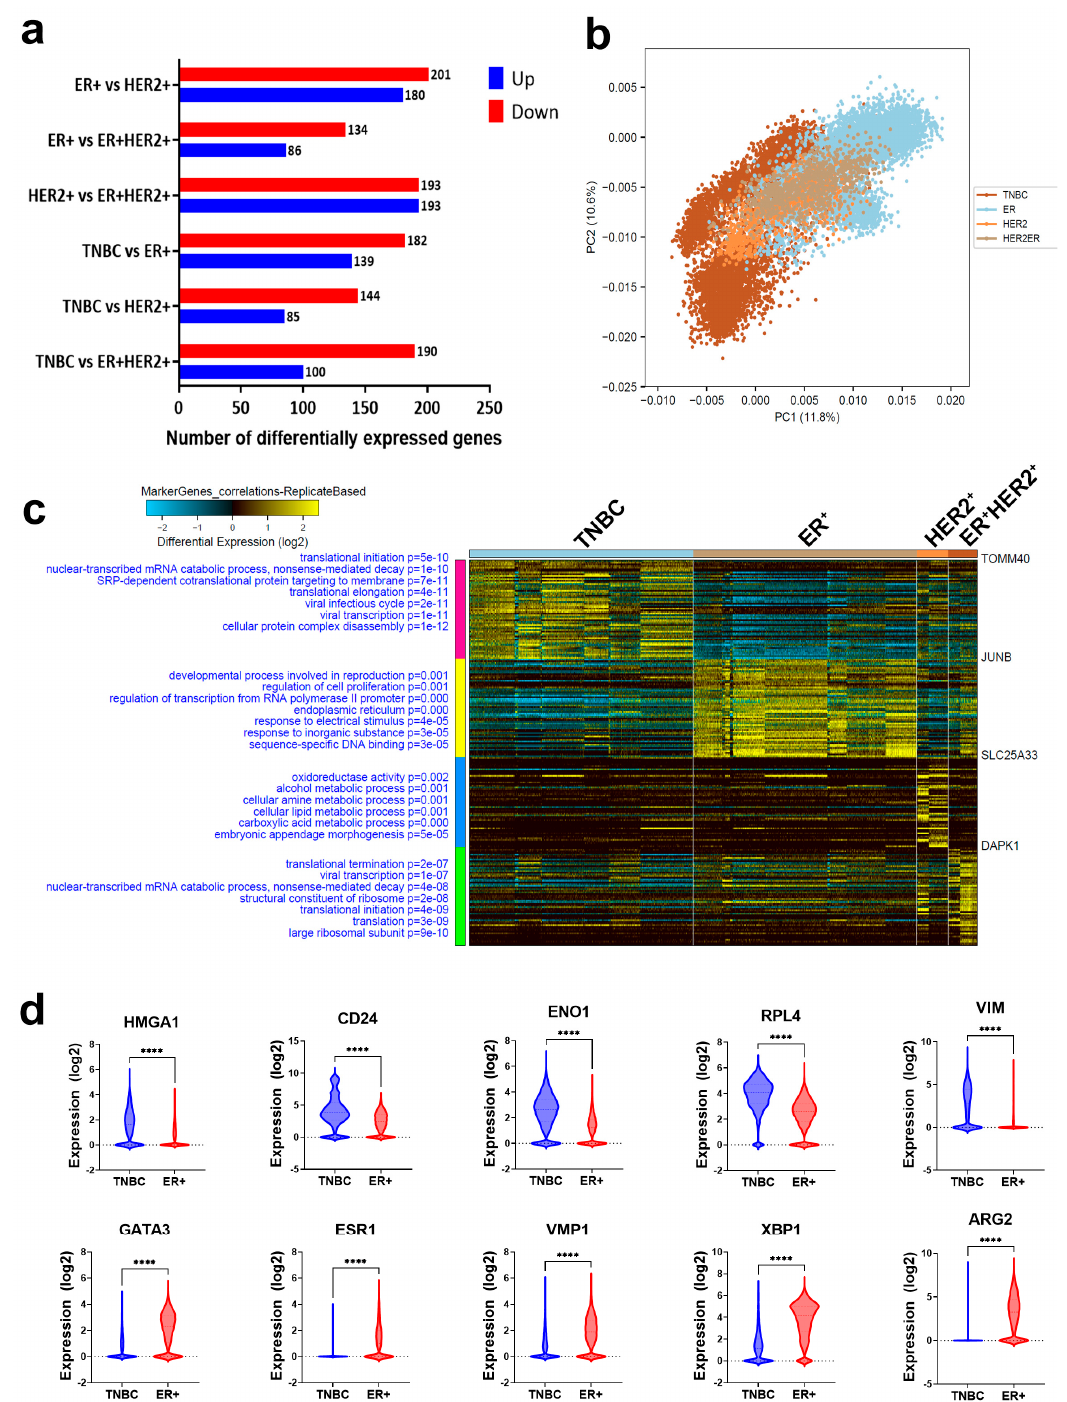
Figure 2. Identi fi cation of gene biomarkers enriched in each BC molecular subtype. ( a ) Bar chart depicting the number of di ff erentially expressed genes (DEGs) in ER + vs. HER2 + , ER + vs. ER + HER2 + , HER2 + vs. ER + HER2 + , TNBC vs. ER + , TNBC vs. HER2 + , and TNBC vs. ER + HER2 + . ( b ) PCA illustrating the segregation of each BC molecular subtype based on the identi fi ed gene markers. ( c ) Heatmap depicting the enriched gene markers associated with TNBC, ER + , HER2 + , and ER + HER2 + employing the MarkerFinder algorithm. The text on the left of each heatmap indicates enriched Go functional categories in each BC subtype and the corresponding enrichment p values. ( d ) Expression of selected genes enriched in TNBC (upper panel) or ER + (lower panel) based on RNA–Seq data. **** p < 0.00005.